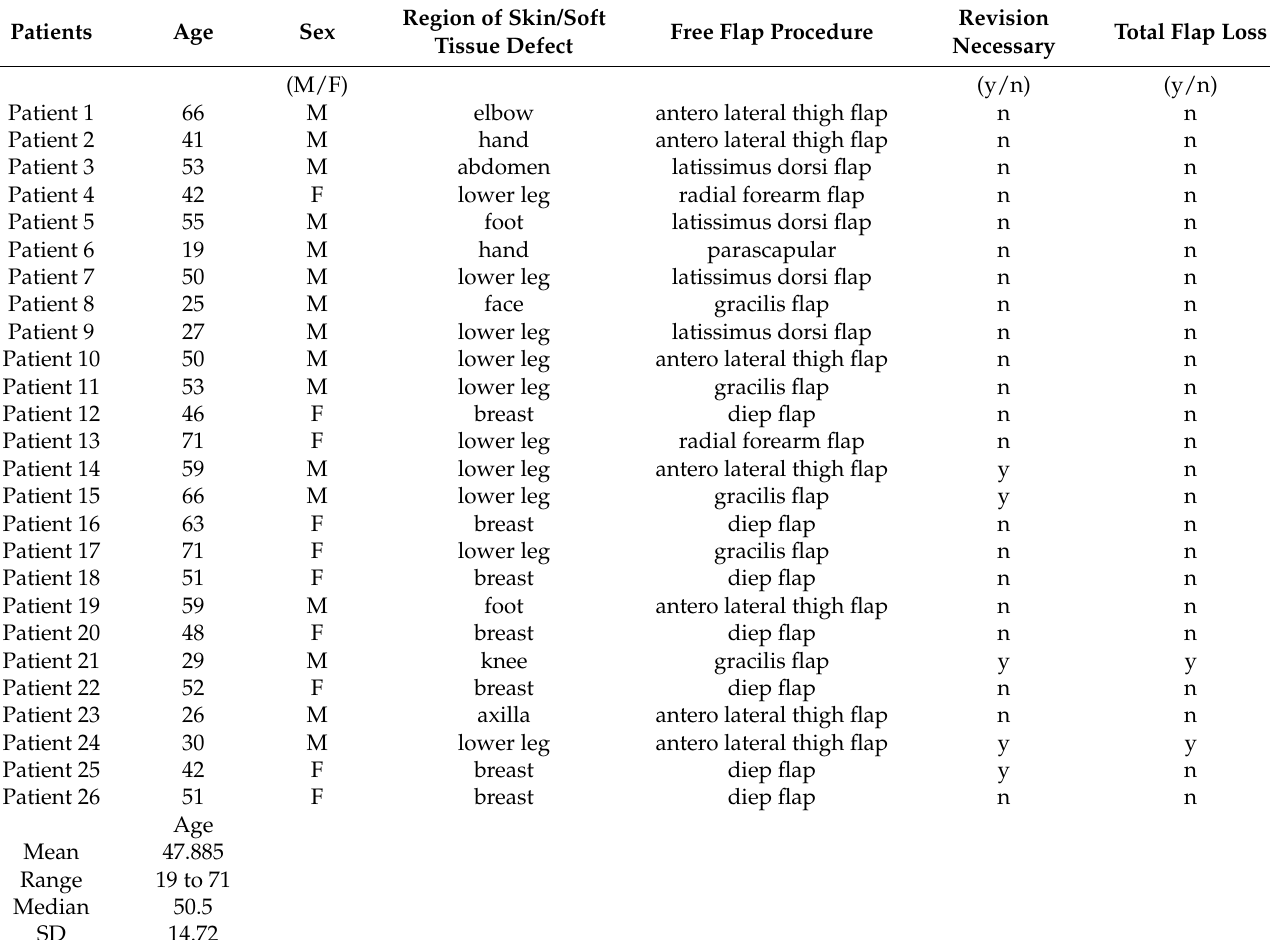
Table 1. Demographical and clinical characteristics of patient